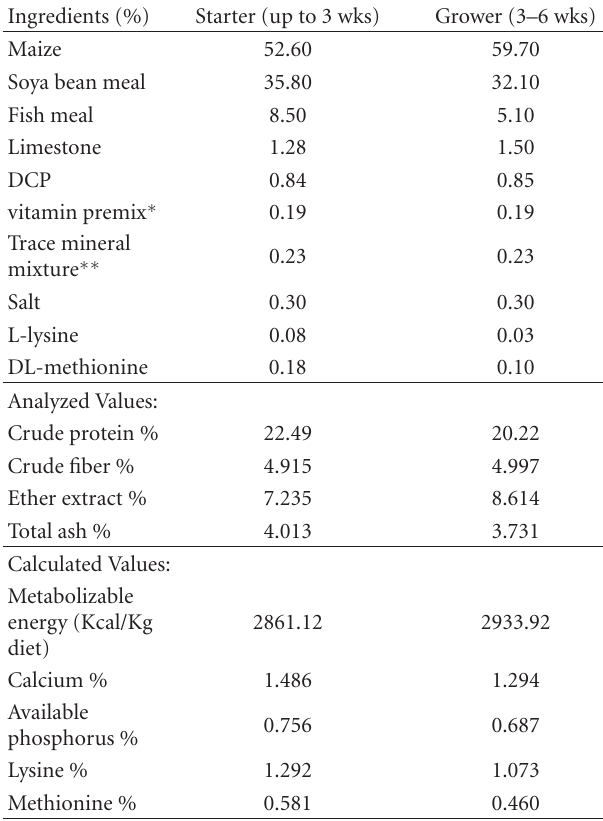
Table 1: Ingredient and chemical composition of experimental ba- sal